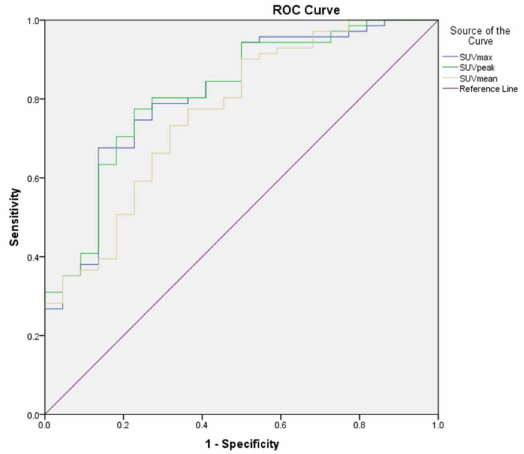
Figure 3. Receiver operating characteristic other-post-transplant lymphoproliferative disorder (PTLD) vs. monomorphic PTLD.